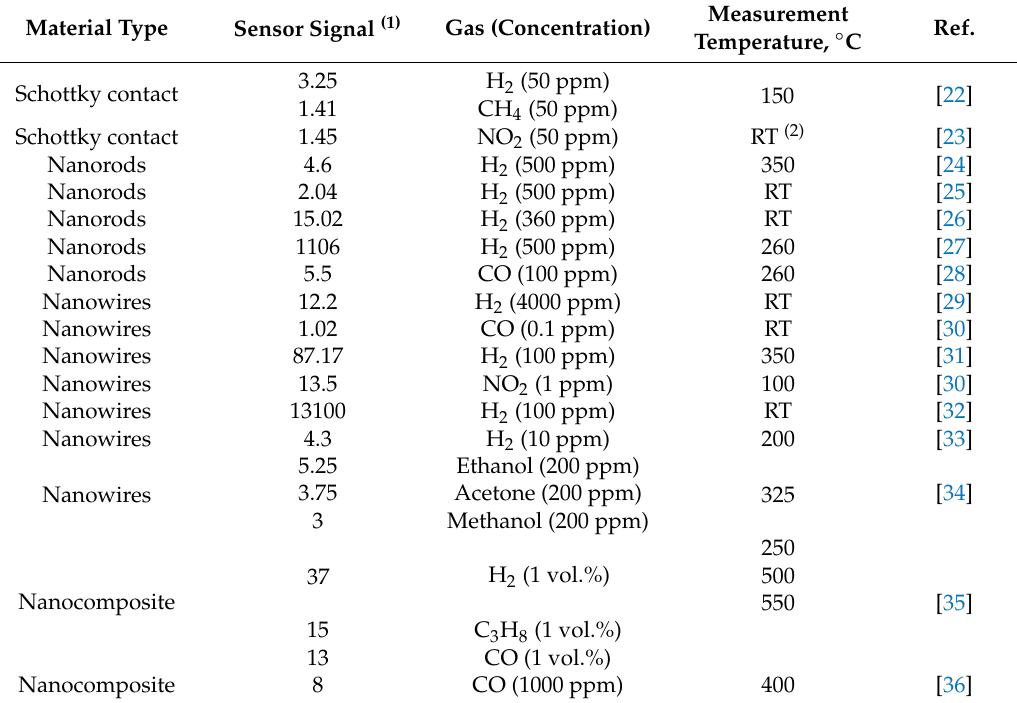
Table 1. Summary of ZnO / Pd materials for gas